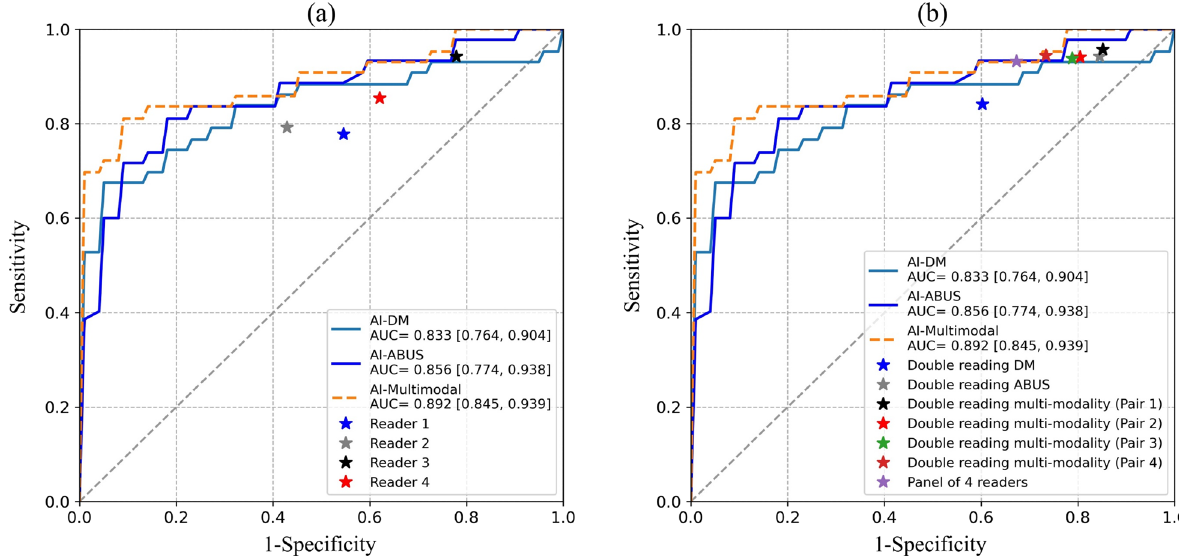
Fig. 2 Operating point of radiologists and receiver operating characteristic curve (ROC) comparison (and their area under the curve, AUC) in observer study cohort. a the ROCs of AI‑DM, AI‑ABUS and AI‑Multimodal, and the operating point of original readers; b the ROCs of AI‑DM, AI‑ABUS and AI‑Multimodal, and the operating point of simulated pairs and the panel of 4 readers